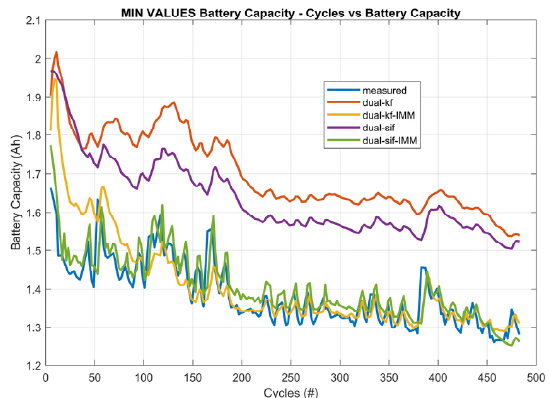
Figure 21. Battery capacity estimation results of each algorithm. Table 6. B034 RMSE: Battery Capacity Using the Minimum at each Estimation cycle.